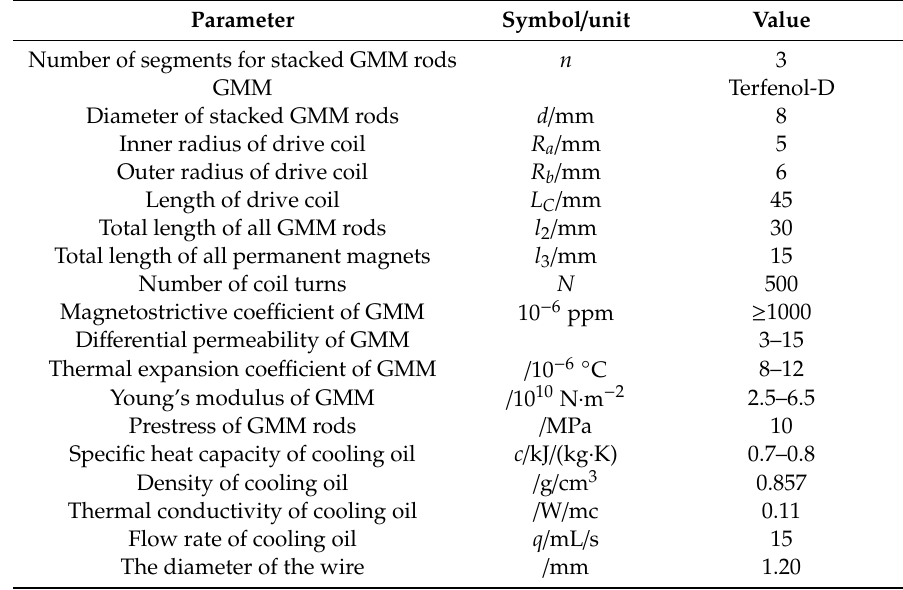
Table 1. The parameters of SGMA